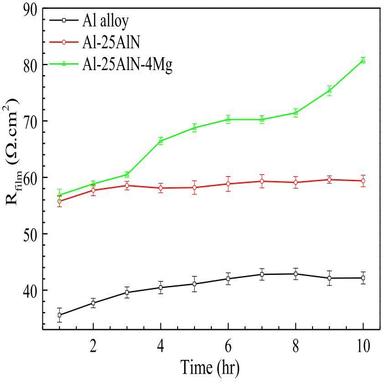
Effect of Mg and AlN composite on: (a) passive layer and (b) charge transfer resistances of the alloys in 0.1 M NaCl solution as a function of elapsed time.